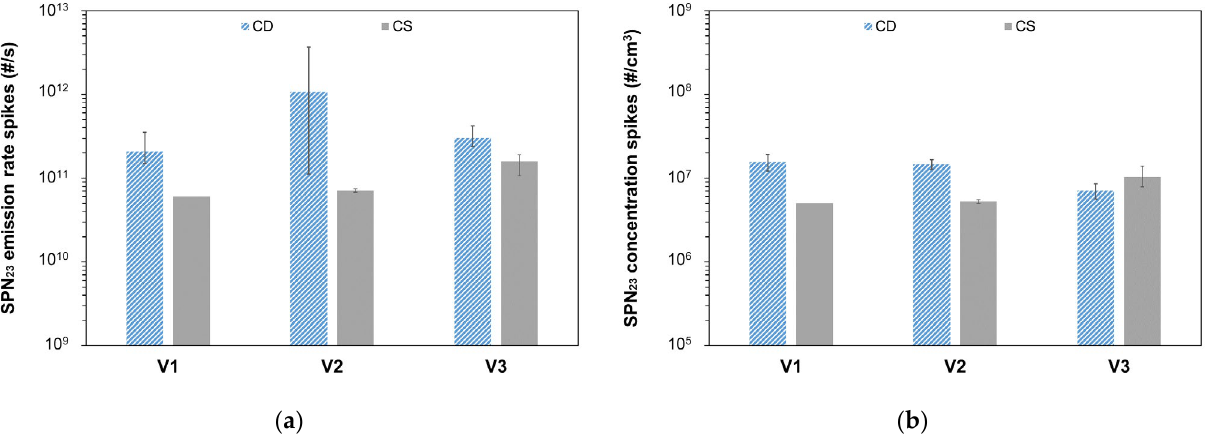
Figure 6. SPN 23 ( a ) emission rate (#/s) and ( b ) concentration (#/cm 3 ) spikes at on-road tests during the cold start of the internal combustion engine. CD stands for charge-depleting tests and CS stands for charge-sustaining tests. The error bars depict the maximum and minimum values.